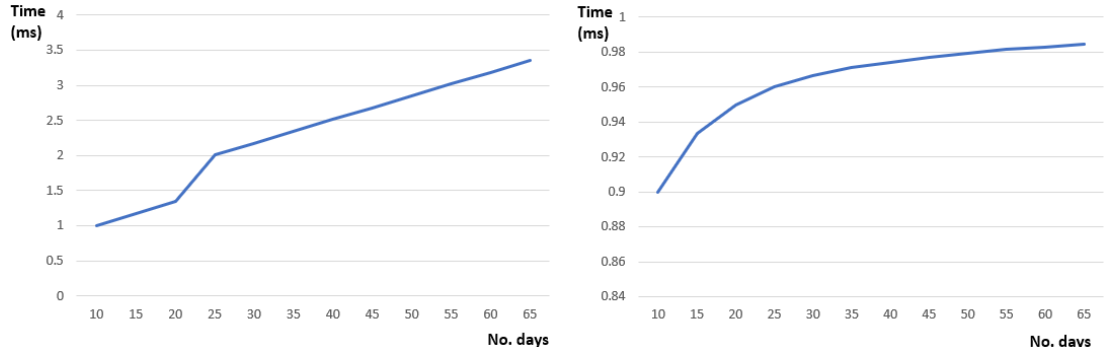
Figure 12. Parameter learning features: ( left ) Learning time and ( right ) probability activity transition (sleep -> eating).